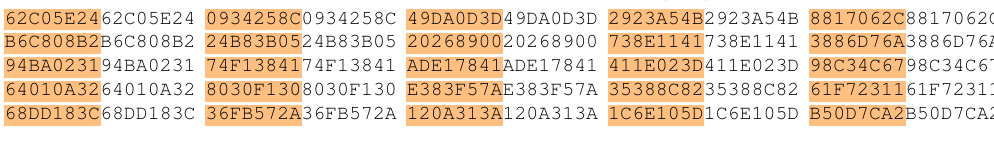
Table 1: A Self-Symmetric state. σ 1 is